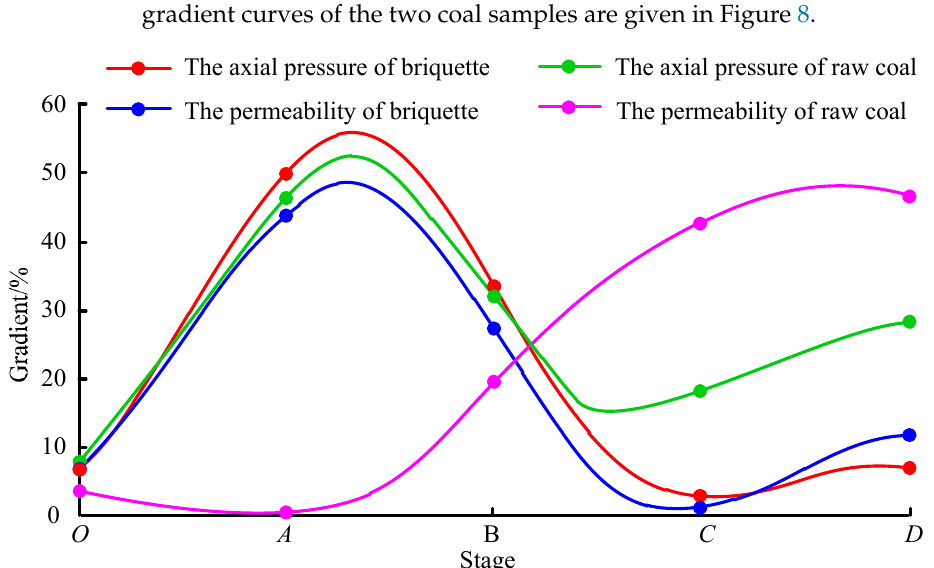
Figure 8. Axial pressure-permeability gradient curves of briquette and raw coal. For briquette, its permeability and axial pressure gradients have the same variation trend, both being the largest (55% and 63% respectively) in the elastic deformation stage (AB section) and relatively small in the other stages. This shows that, under triaxial com- pression, the permeability of briquette is significantly affected by the axial stress and is the most sensitive to axial pressure in the elastic deformation